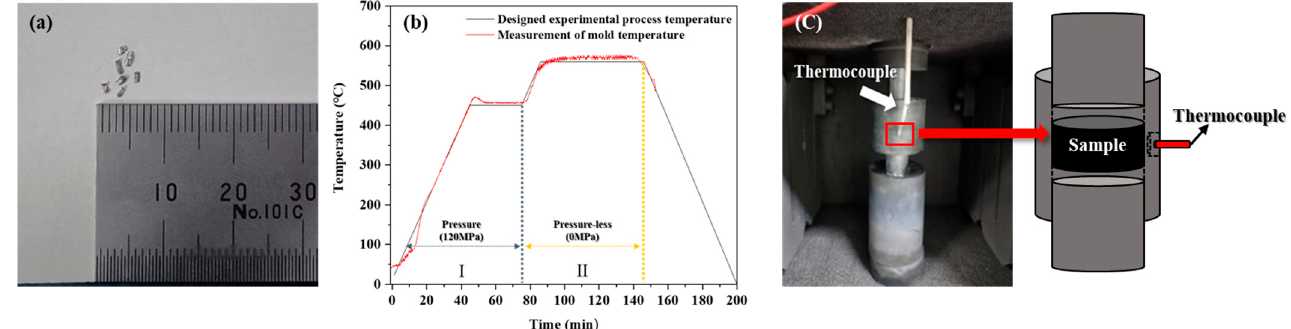
Figure 1. ( a ) Al chip size measurement; ( b ) Schematic of AlG foam process temperature and actual mold temperature measurements; ( c ) Mold temperature measurement method.